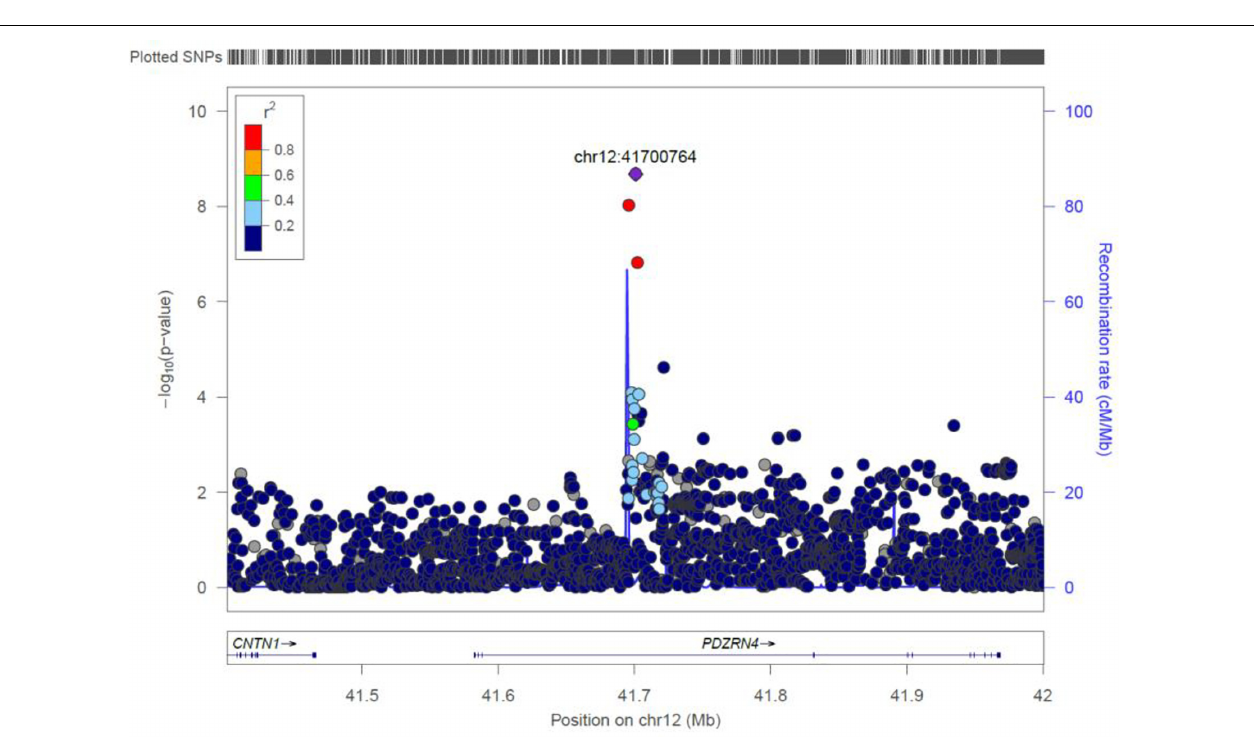
Frontiers in Genetics |